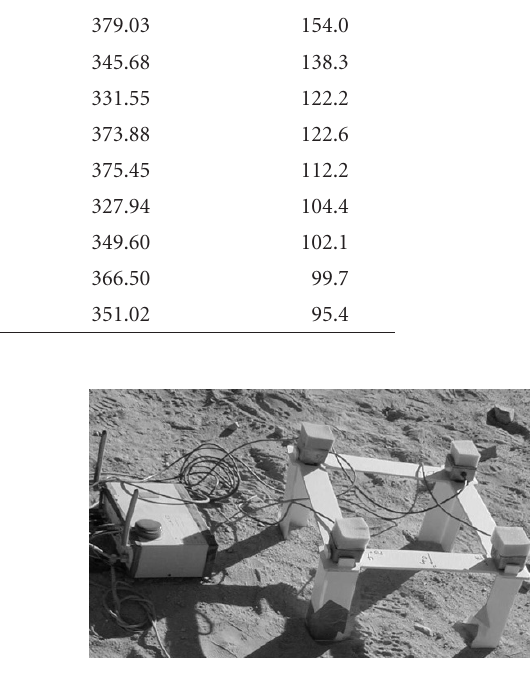
Figure 10: AAVP7A1 tracked, armored assault vehicle. The sensor network consisted of a total of 70 WINS 2.0 nodes from Sensoria Corp. A picture of a node is shown in Figure 11 along with a DOA array. The node specifications are provided in Table 5. Among the 70 nodes, 20–25 nodes were available for our use. They are randomly positioned at the intersection of two dirt roads. The sensor layout and the